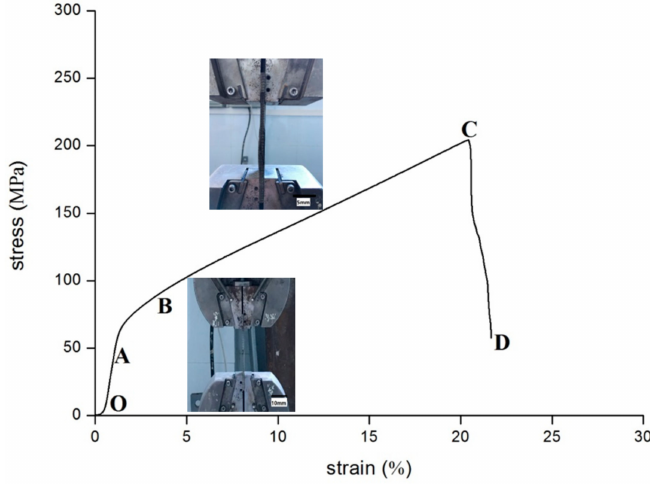
Figure 5. The typical tensile stress-strain curve for